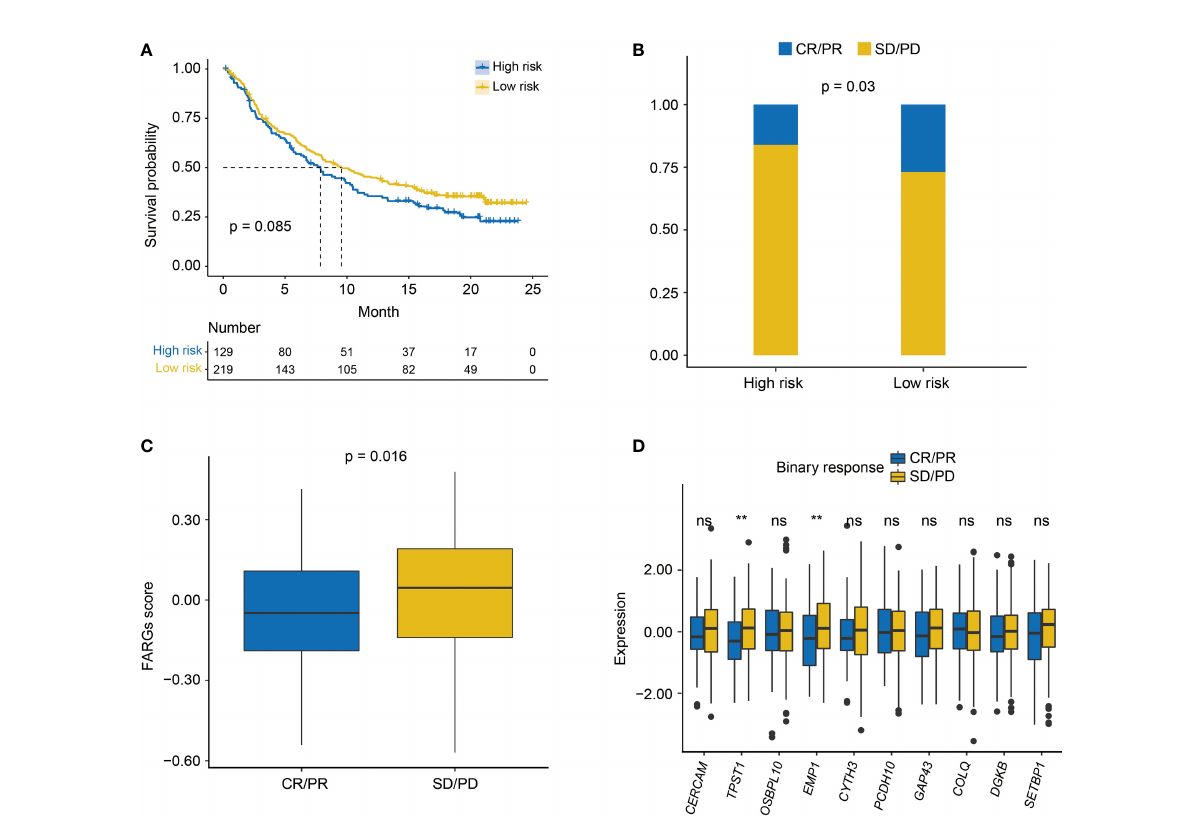
FIGURE 10 The evaluation of immunotherapy response by the FARG signature in the IMvigor210 cohort. (A) The Kaplan – Meier curve analysis between high- and low-risk groups in the IMvigor210 cohort. (B) The proportion of BC patients made complete/partial response (CR/PR) or kept a stable/ progressive disease (SD/PD) in high- and low-risk groups. (C) The comparison of FARG score between patients making complete/partial response (CR/PR) and those who kept a stable/progressive disease (SD/PD). (D) The lower expression of TPST1 and EMP1 was signi fi cantly associated with the better immunotherapy response of anti-PD-L1/PD-1 treatment in the analysis of the IMvigor210 cohort. ** indicated p < 0.01, ns indicated no statistically signi fi cant